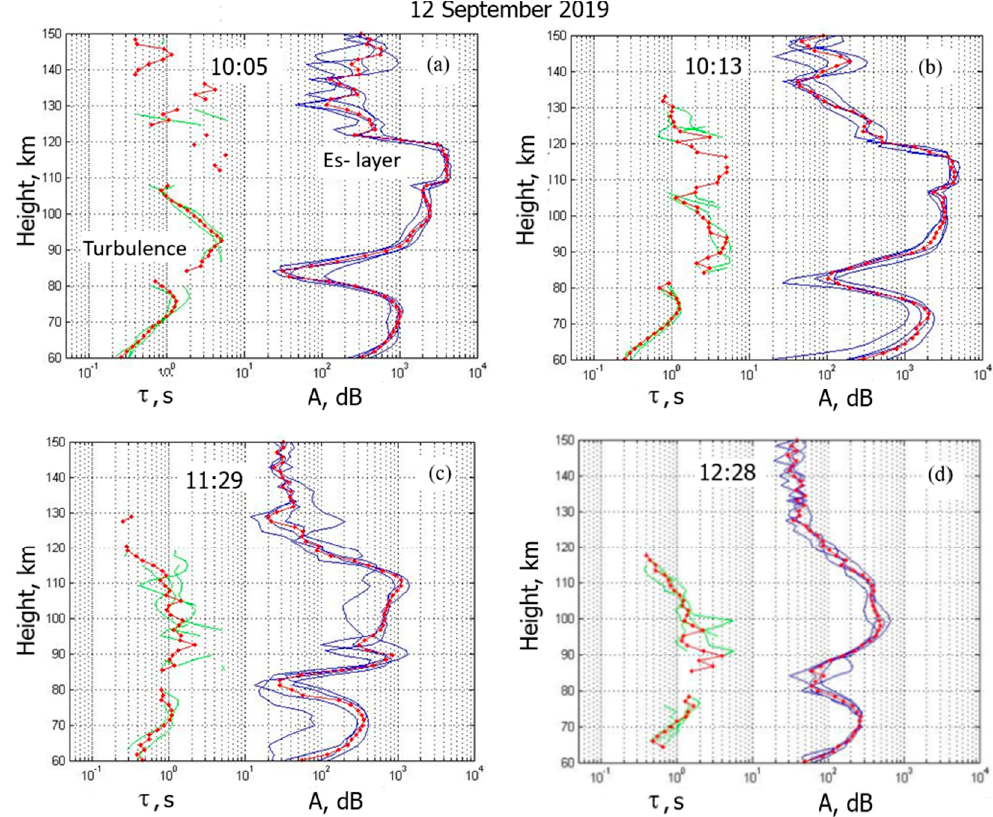
Figure 6. Height dependences of the amplitude A(h) ( right curves) and relaxation time τ (h) ( left curves) of the API scattered signal in the D-region (h = 60–80 km) and in the E-region (h = 90–120 km) for four sessions of the API recording with a duration of one minute on 12 September 2019. The designations are the same as in Figure 5. Session time is shown in the figures in the format hours: minutes ( a ) 10:05, ( b ) 10:13, ( c ) 11:29, ( d ) 2:28.